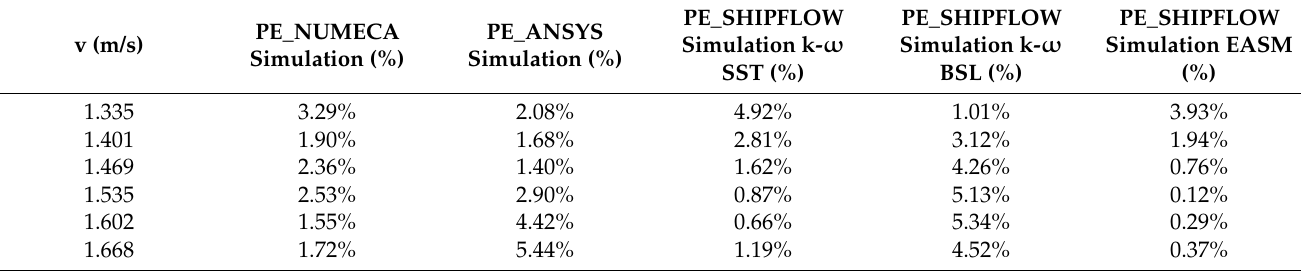
Table 2. Percentage error between experimental test and each CFD simulation for Rt.